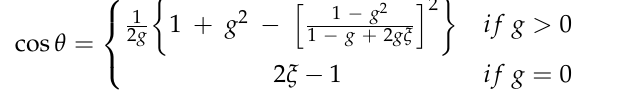
) for different radius ratios ( ϕ r ef f